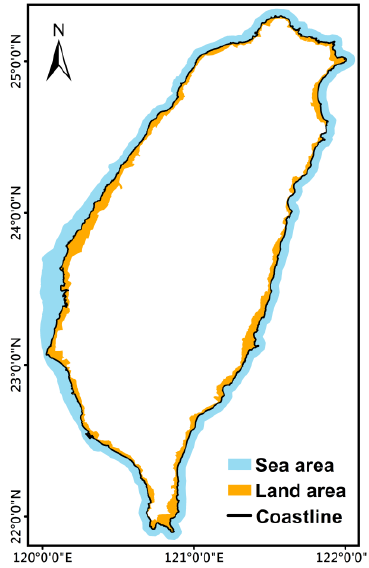
Figure 2. The coastal zone of Taiwan. The black line shows the coastline, and brown and cyan colors represent the land areas of the coastal zone (LACZs) and the sea areas of the coastal zone (SACZs), respectively.